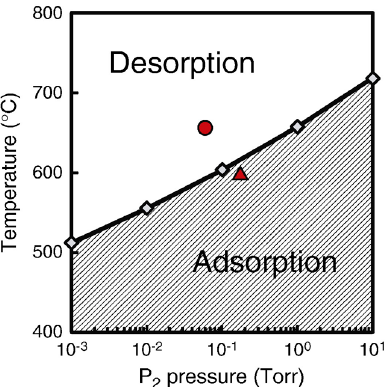
Figure 27. Calculated phase diagrams functions of temperature and pressure for adsorption–desorption behavior of a P atom in the growth process shown in Figure 26. Red circle and triangle represent the growth conditions (A) and (B), respectively. Reprinted with permission from [98]. Copyright (2013) by Elsevier.